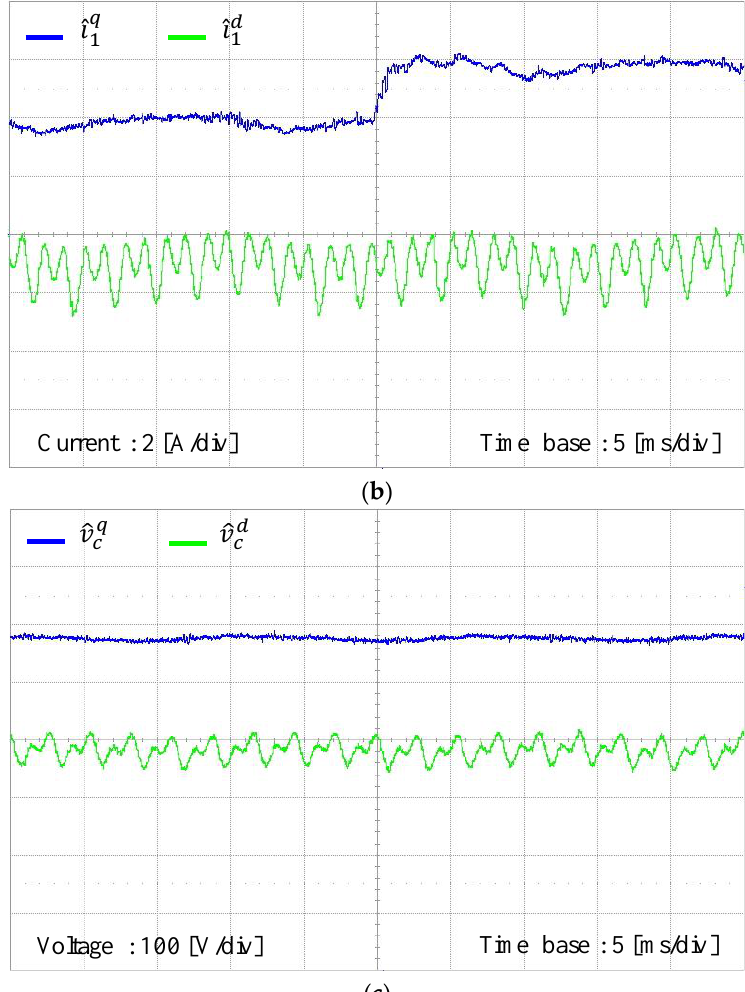
Figure 16. Experimental results for the estimated states with the discrete-time full-state observer under step change in q -axis current reference. ( a ) Responses of estimated grid-side currents at the SRF; ( b ) responses of estimated inverter-side currents at the SRF; ( c ) responses of estimated capacitor voltages at the SRF.